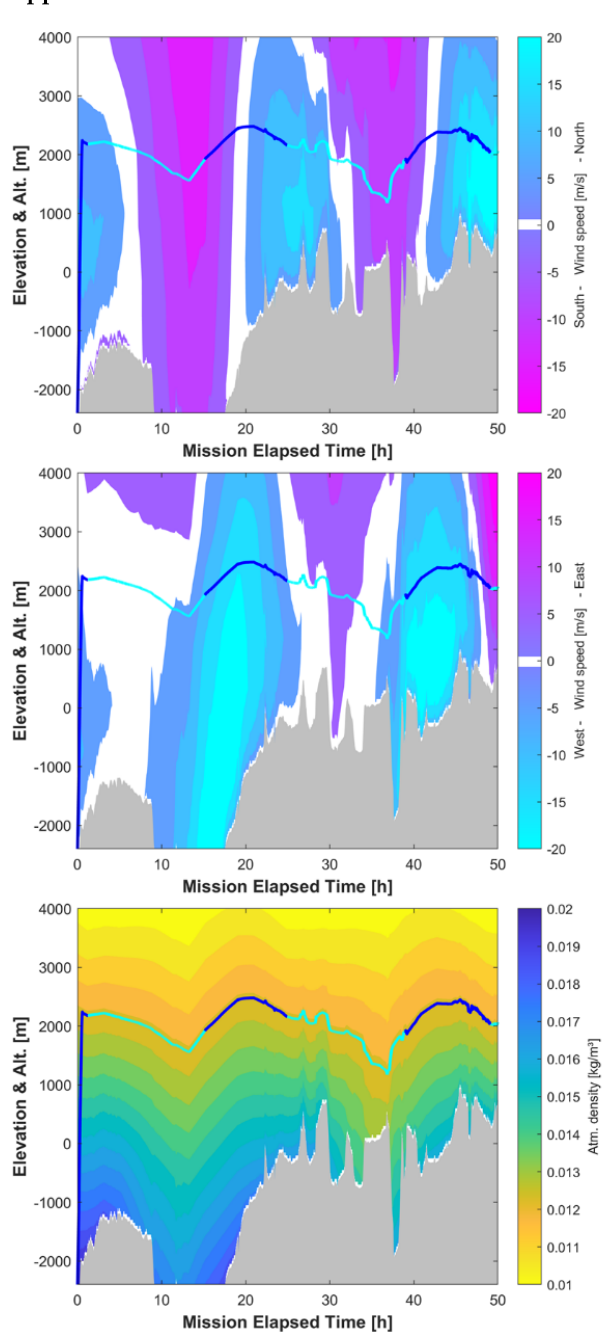
Figure A1. Altitude/elevation charts for the Ls = 240° scenario showing the color-shaded variations over altitude and along time of meridional ( top ) and zonal ( middle ) winds and atmospheric density ( bottom ). The gray shaded area represents the terrain elevation at the momentary balloon position.